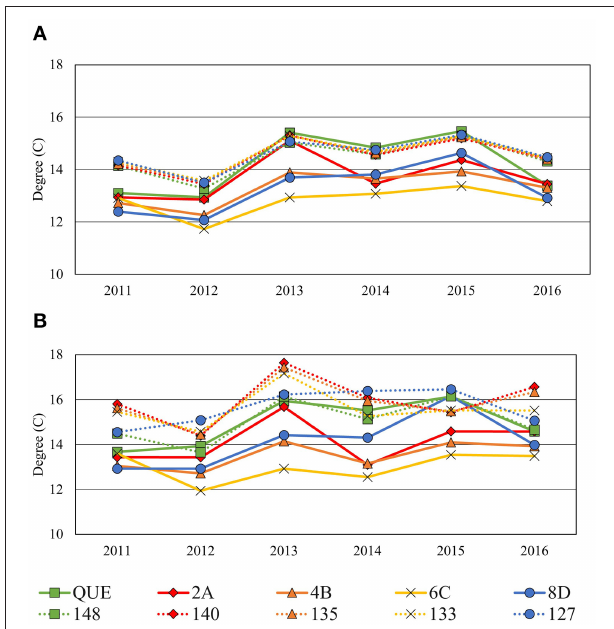
FIGURE 6 | Simulated and measured (A) MWAT and (B) MWMT temperatures for stream temperature stations located throughout the South Fork stream network. Solid lines represent data collected at Caspar Creek ( Figure 1 ), while dashed lines of the same color represent data produced from the corresponding, modeled stream